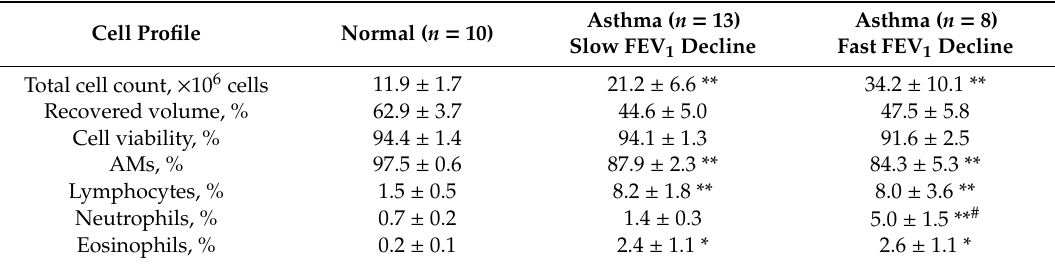
Table 2. Characteristics of bronchoalveolar lavage.